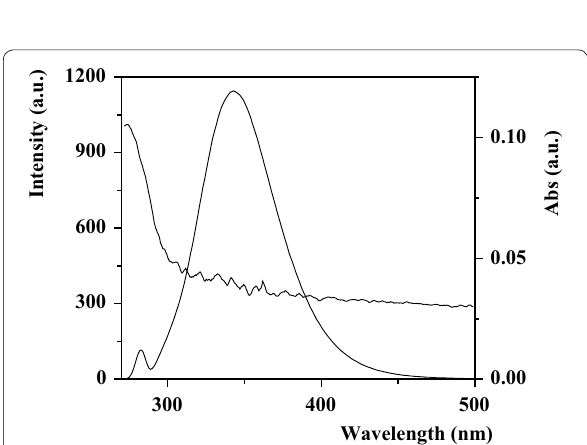
Fig. 7 Effect of site maker probes on the fluorescence of HSA oniflorin system ([HSA]